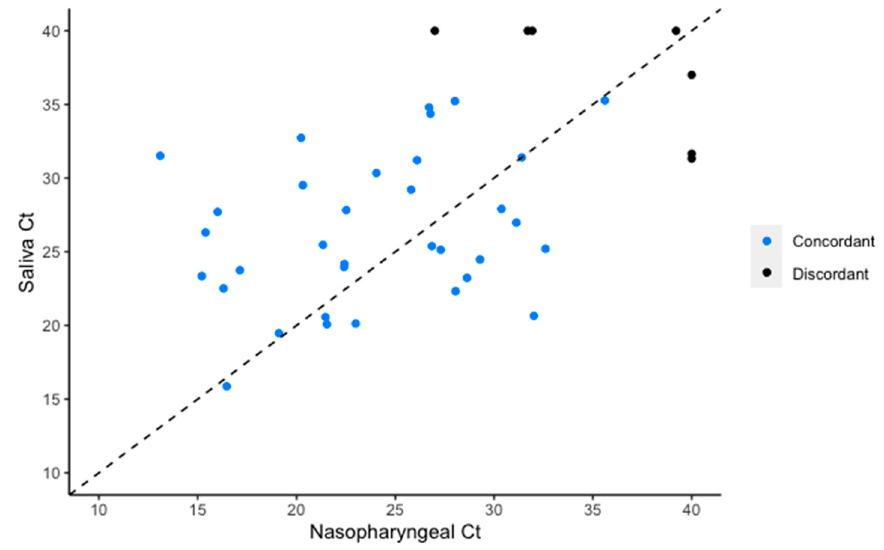
Figure 1. Cycle threshold values for the E gene target of SARS-CoV-2 RNA retrieved from individuals who were concordantly positive by nasopharyngeal swab and